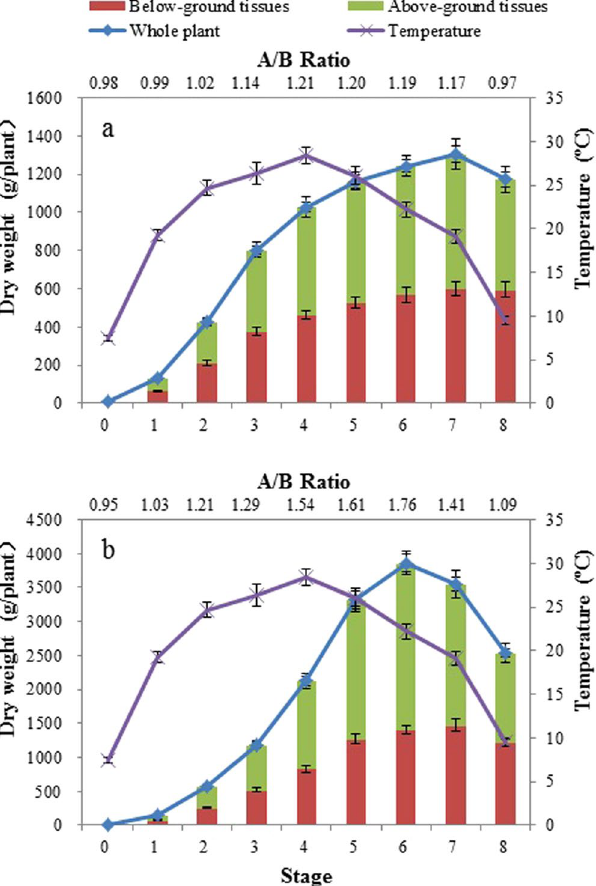
Figure 2. Variations of the plant dry weight of the tested vegetation with time being consistent with the variations of temperature in the eight stages; A/B Ratio was the ratio of above-ground tissue dry weight to below-ground tissue dry weight, ( a ) Iris pseudacorus , ( b ) Thalia dealbata .